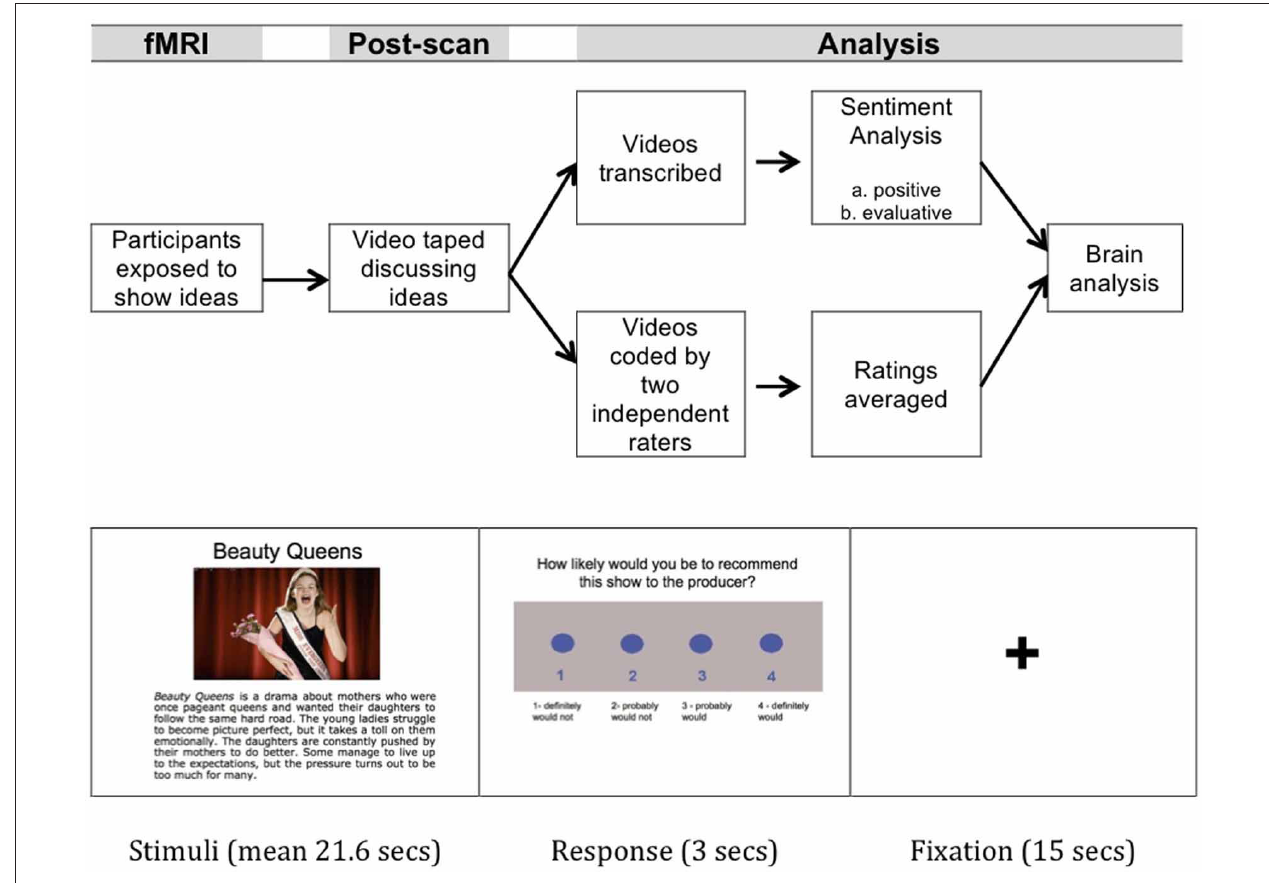
FIGURE 1 | Participant procedure and data analysis flow. Participants were exposed to an initial set of ideas while neural activity was monitored throughout their brains using fMRI. They were then videotaped discussing